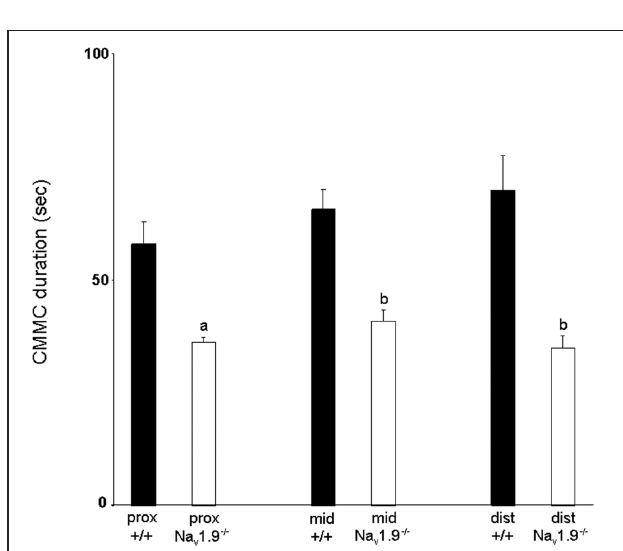
FIGURE 4 | Graphic representation of the duration of CMMCs in the proximal, mid- and distal colon of wild-type and Na v 1.9 − / − mice. The duration of CMMCs in Na v 1.9 − / − mice was found to be significantly shorter than in +/+ mice. a P < 0 . 05, b P < 0 . 01 vs. + / + mice.